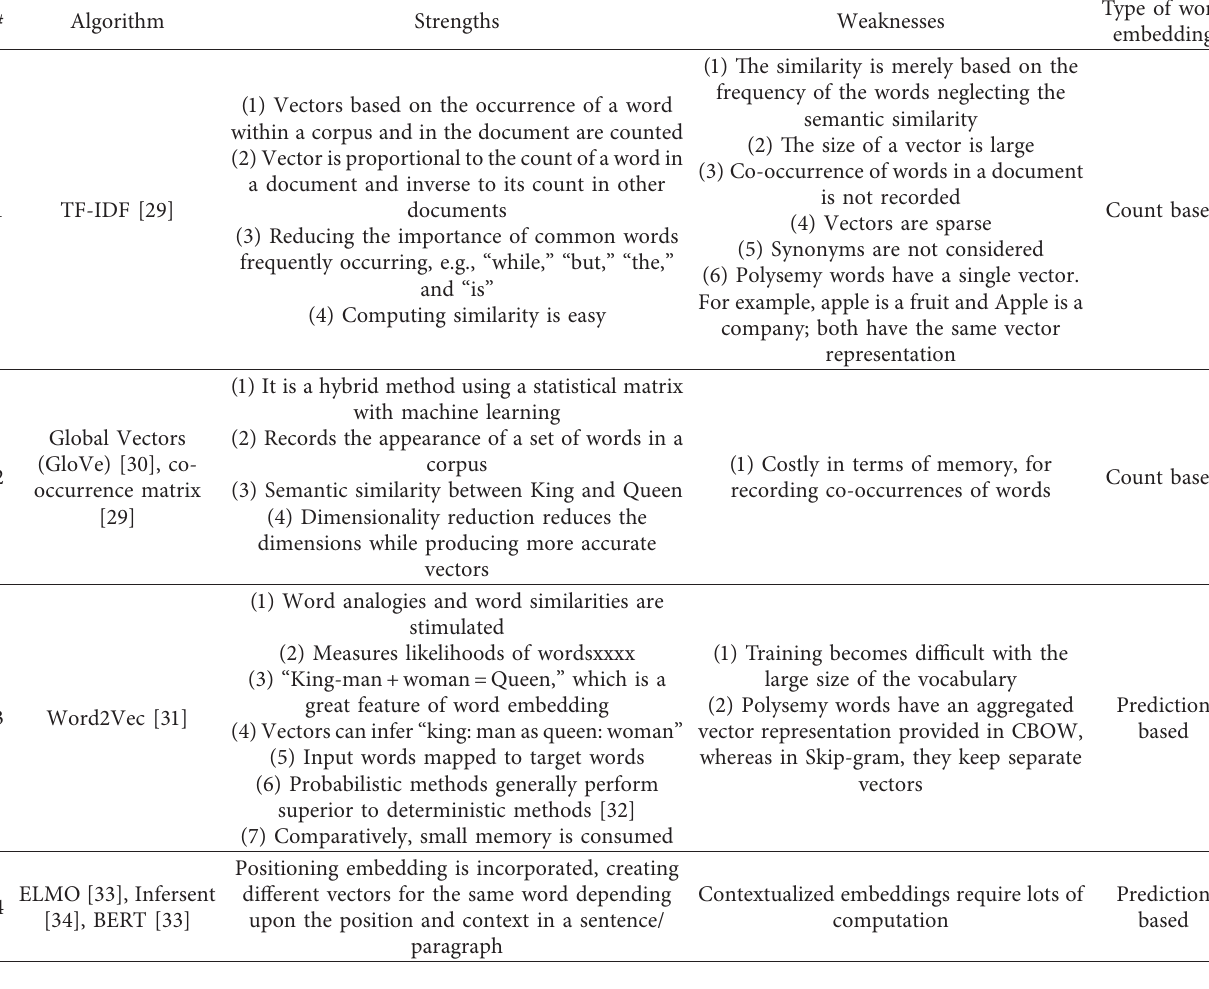
Table 4: Overview of word embedding techniques with their strengths and weaknesses.